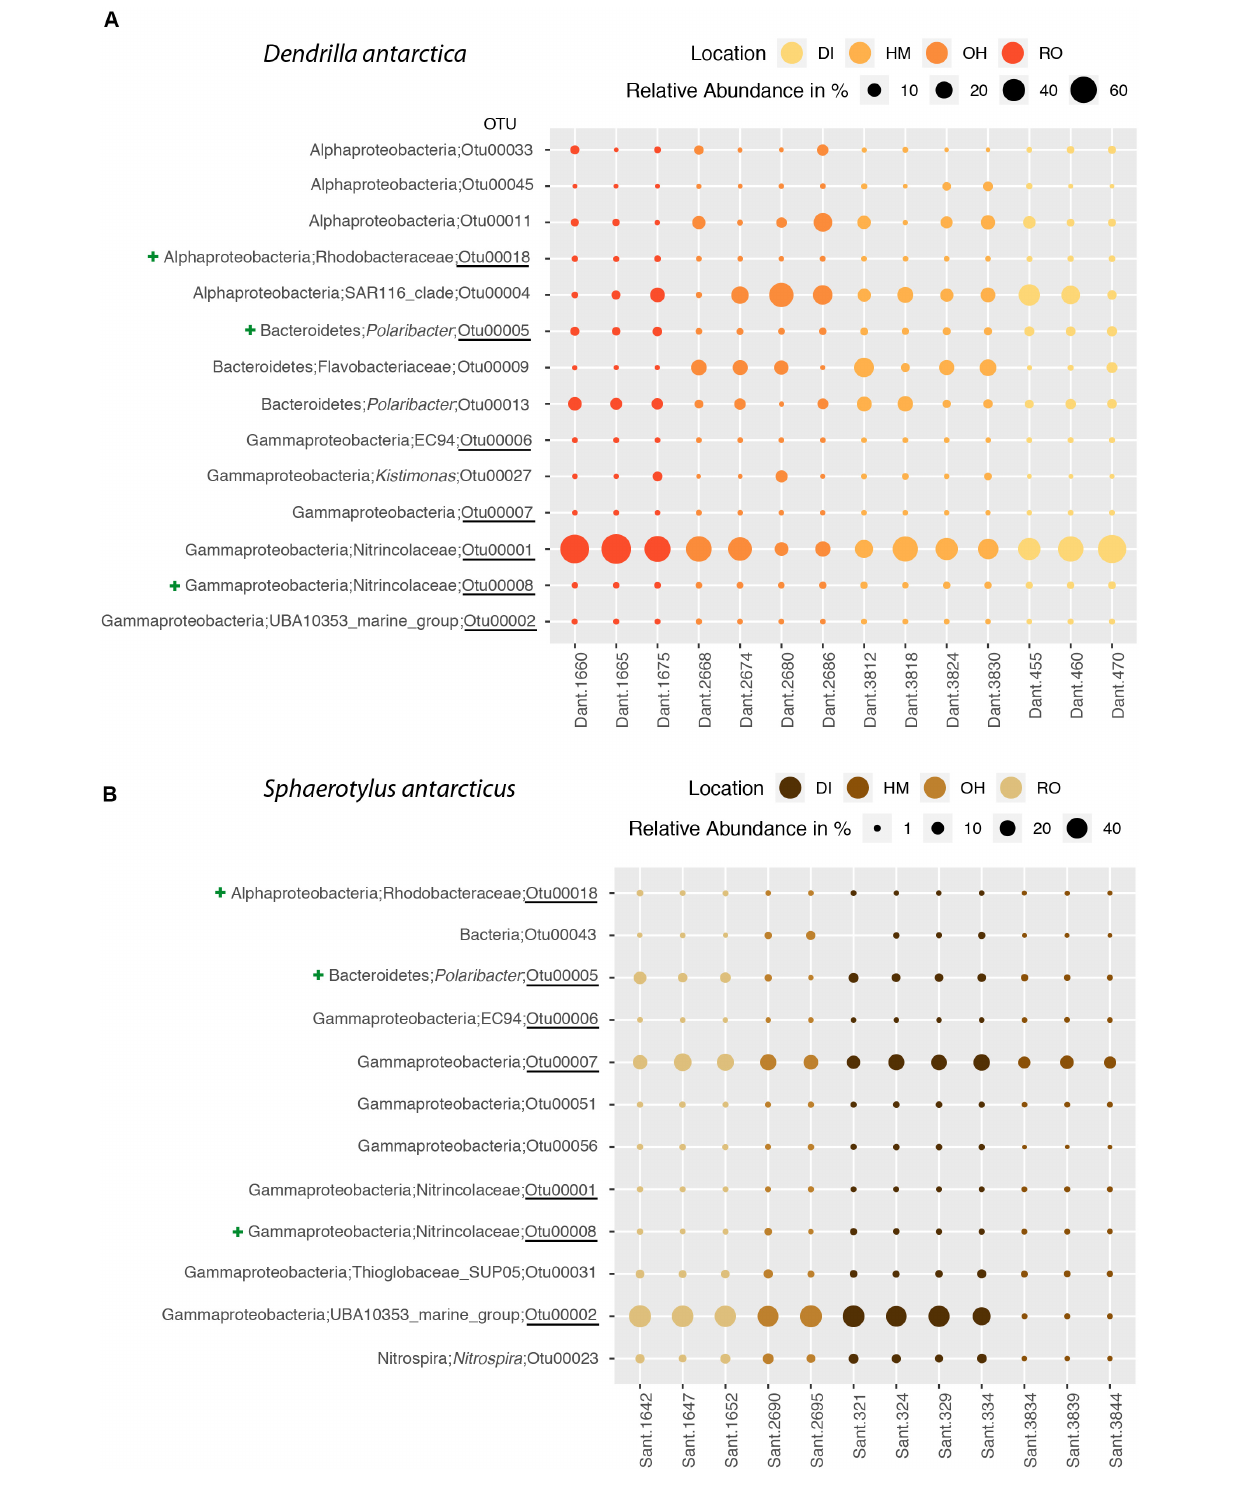
FIGURE 3 | Bubble chart of core (underlined) and enriched variable OTUs of Dendrilla antarctica (A) and Sphaerotylus antarcticus (B) among locations defined at > 0.1% relative abundance. OTU relative abundances are represented by the size of the bubbles (key on the top of each chart; notice the different scale between A and B). The smallest taxonomical level for each OTU is also shown. Location key: O’Higgins (OH), Half Moon Island (HM), Deception Island (DI), and Rothera (RO). We also show with a green cross those OTUs enriched in seawater samples.